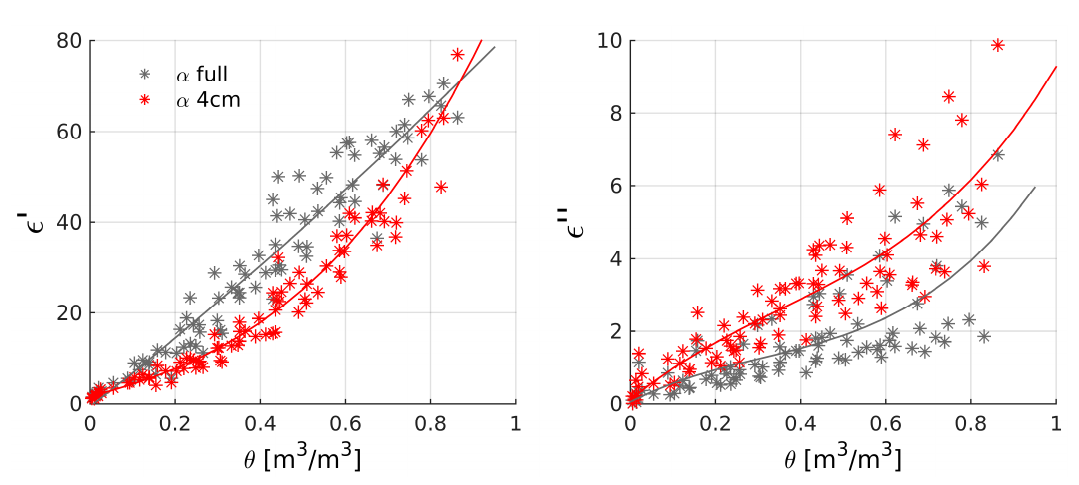
Figure 3. Estimated permittivities, ( a ) real ε′ and ( b ) imaginary ε″ part, of all organic samples measured over the entire wetness range θ and at room temperature (filtered as specified in Section 2.2.3), using a filling factor α for the full tube length (grey) and specifically calibrated for the 4 cm tube insertion depth (red).